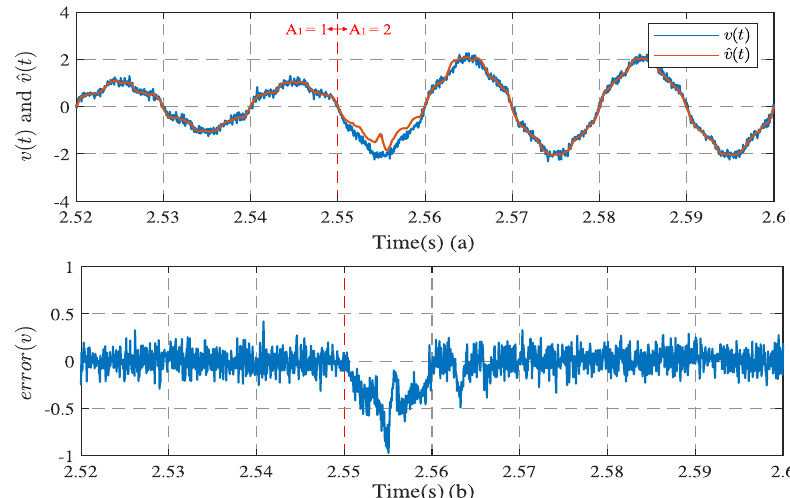
Figure 11. Observations of a harmonic observation system with the cascaded 3CS method after the addition of white noise: ( a ) Tracking of the input signal and; ( b ) error.